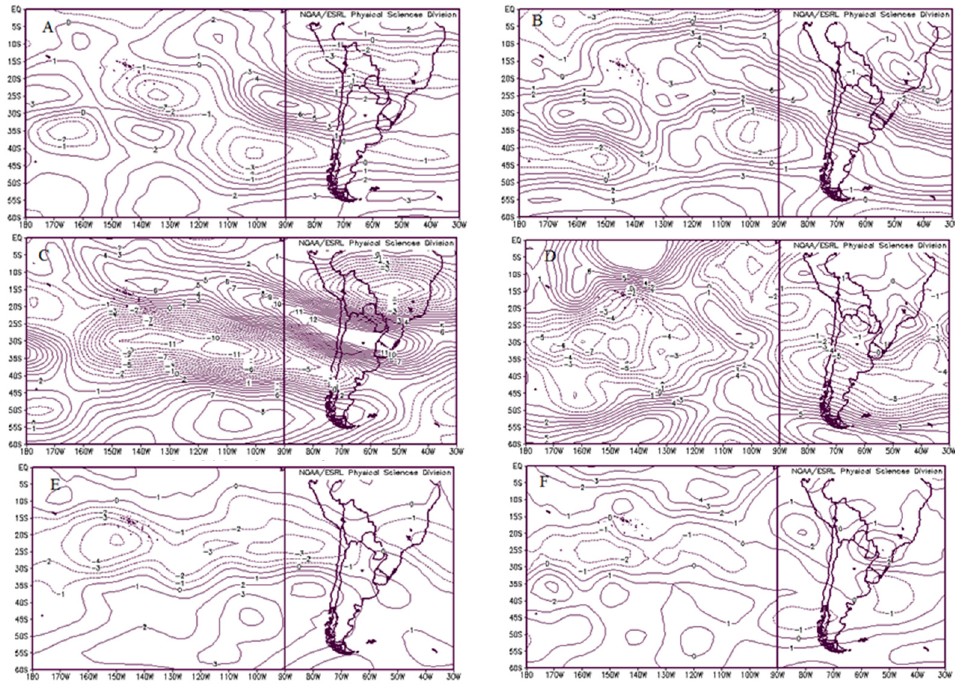
Figure 3. The 200 hPa wind speed anomalies (m s − 1 ) for ( A , C , E ) June prior to the years used in Figure 2; and ( B , D , F ) years corresponding to Figure 2. The contour intervals are 1 m s −